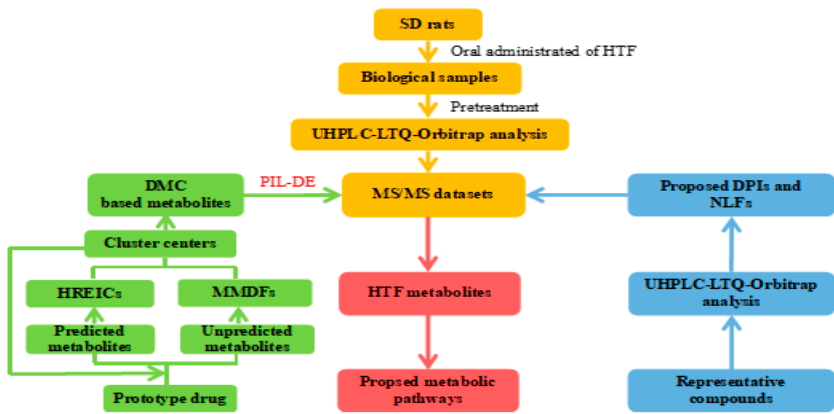
Figure 2. Summary diagram of the developed strategy and methodology.